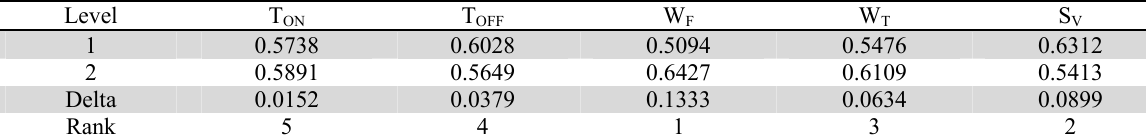
Response table for Grey Relational Grade